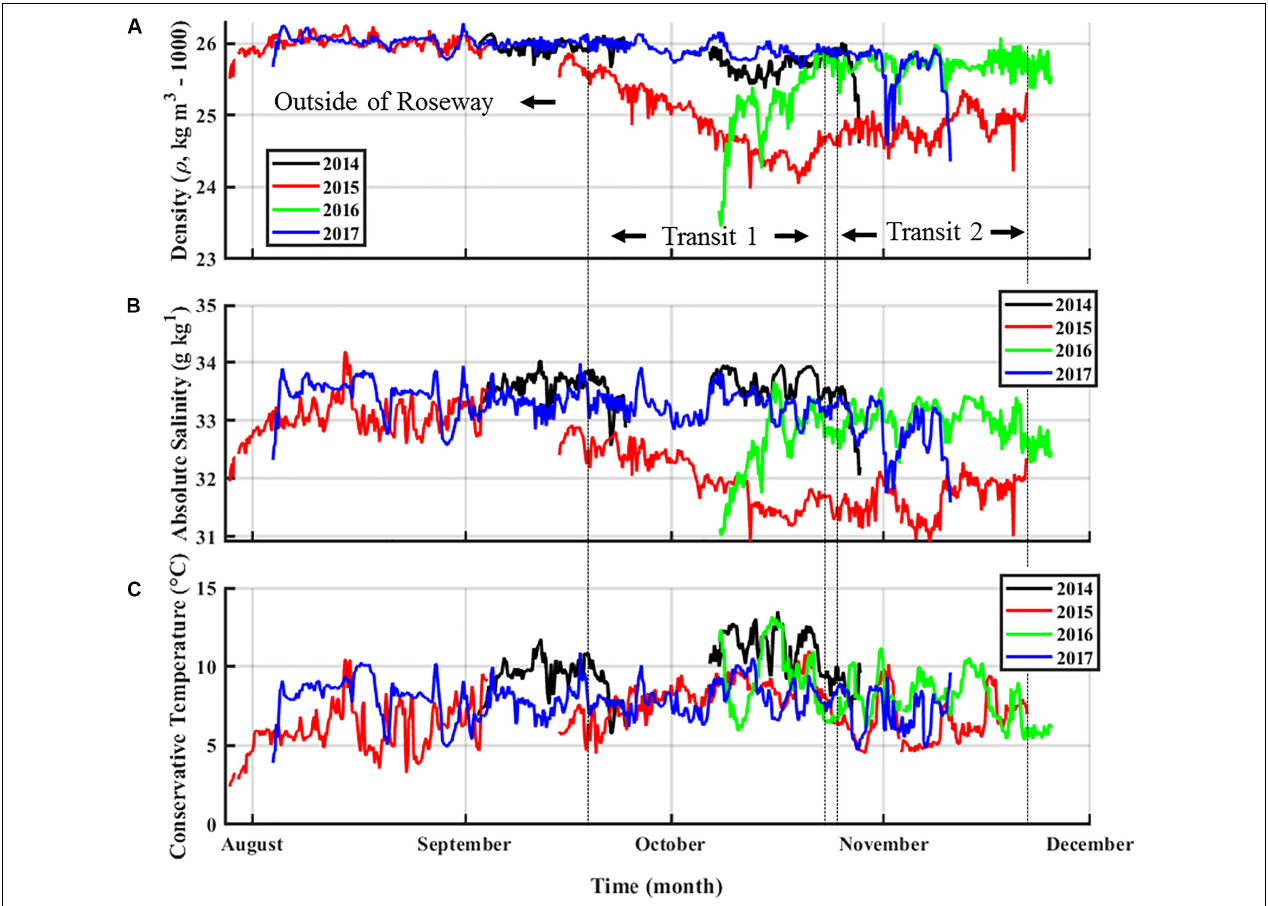
FIGURE 4 | Time series of water density ( σ t , kg m − 3 , A) , absolute salinity (g kg − 1 , B) , and conservative temperature ( ◦ C, C) from August through November from 4 years of glider-based observations in or near Roseway Basin (2014–2017). The red line shows the 2015 survey data. Data is the hourly average from 50–100 m. Vertical dashed lines delineate (from left to right) data outside of Roseway Basin, from Transit 1, and from Transit 2 for the 2015 glider survey